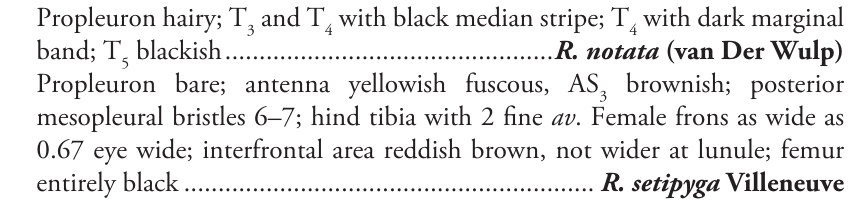
Key to the species of Strongyloneura 1 Male sternite without brush-like tuft of hairs or bristles except ST tral side of hind coxa with yellow fine hairs and black hairs .... S. prasina Bigot – Third sternite with large brush-like tuft of hair ...... S. diploura Fang & Fan – Third sternite without tuft of hair; ST